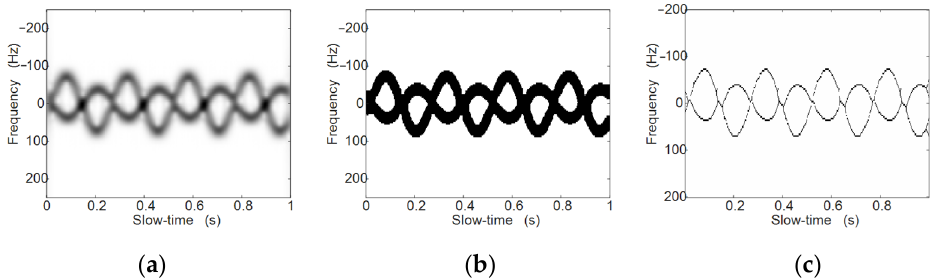
( b ) Figure 7. Simulations of the micro-Doppler effect of the precession cone-shaped target perpendicu- lar to the radar LOS. ( a ) Echo micro-Doppler frequency curves. ( b ) Theoretical micro-Doppler fre-